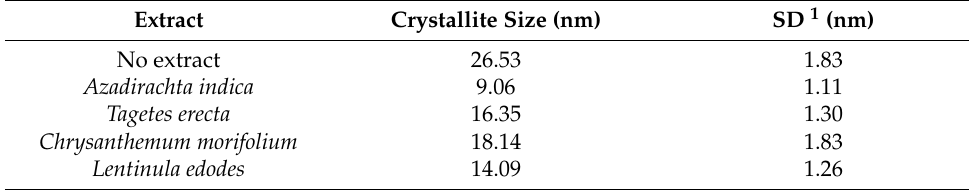
Table 2. Crystallite size of the ZnO